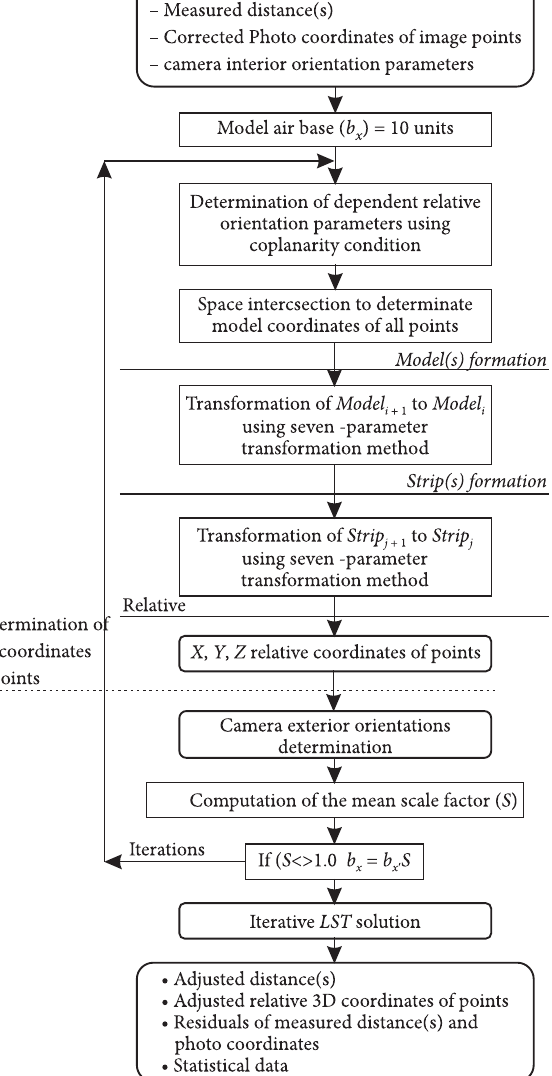
Figure 1. The main computational steps of the proposed